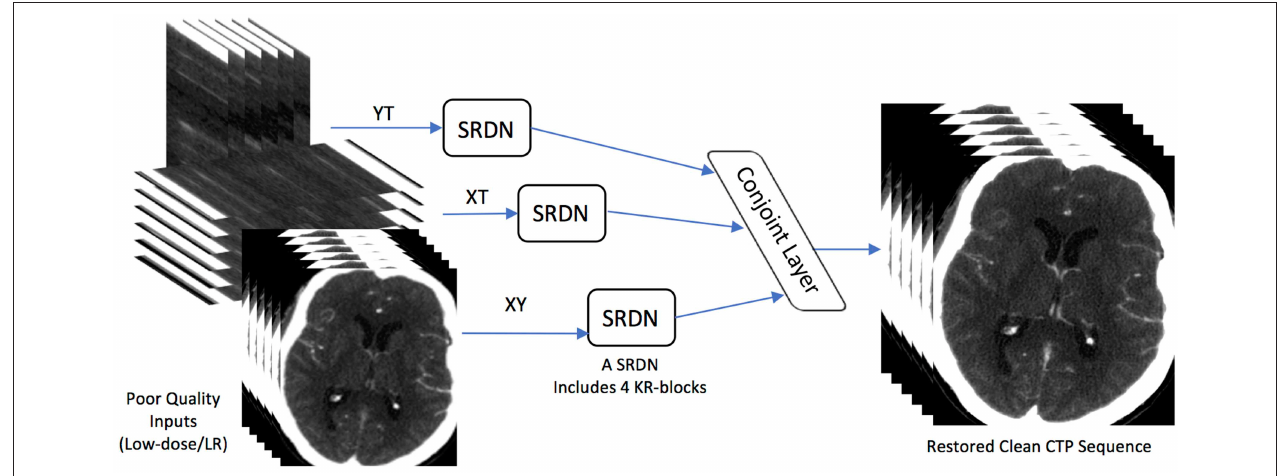
FIGURE 2 | STIR-Net Architecture. STIR-Net takes low-dose inputs from three cross-sections: XY, XT, and YT. Each cross-section go through one SRDN, and the outputs of SRDNs meet in a conjoint layer, which calculates the mean of the three output volumes form SRDNs to provide the final results of STIR-Net.